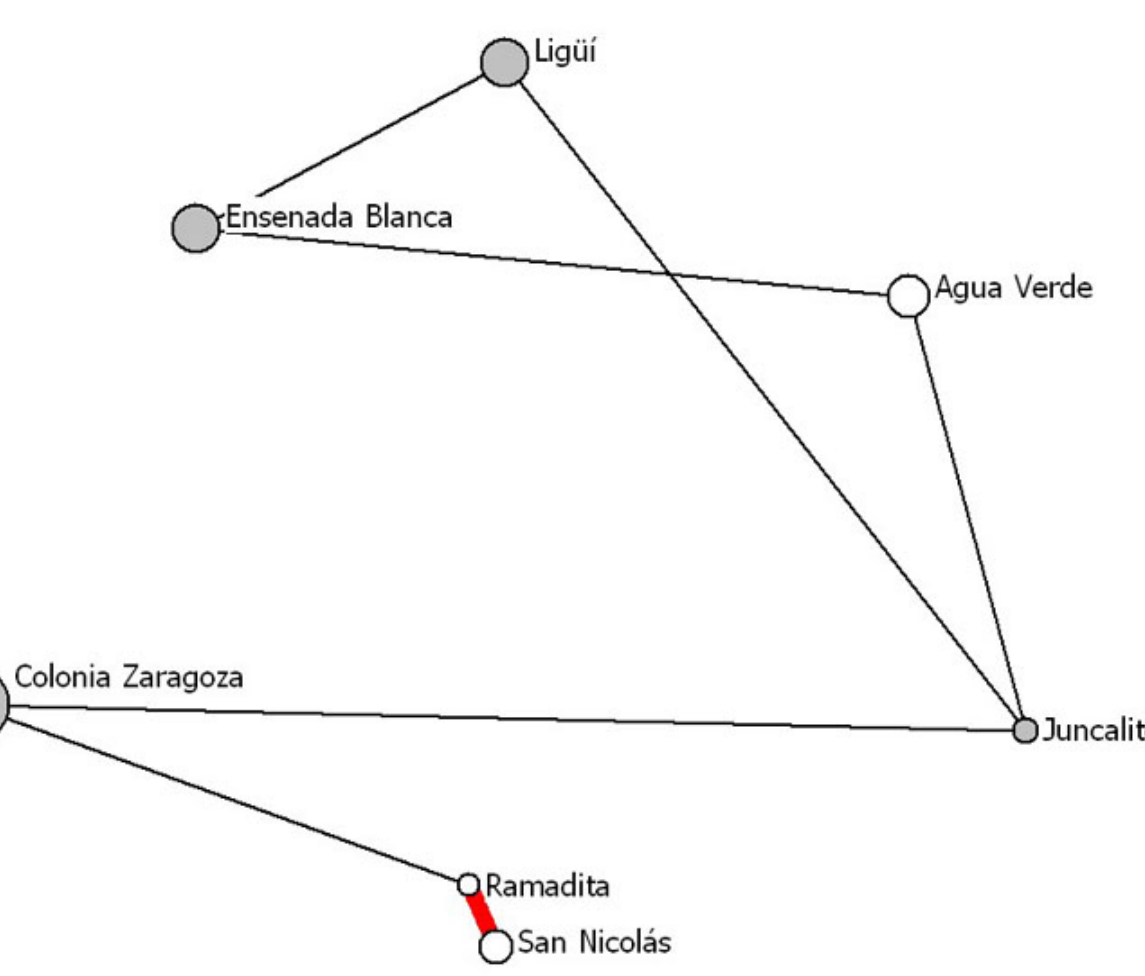
Fig. 6. Multi-dimensional scaling plot showing the kinship linking structure among the seven communities. The size of each node (community) is proportional to the number of fishers considered in each community; communities with high resource scarcity are shown with gray circles and communities with low resource scarcity are shown with white circles. The thickness of intercommunity links is proportional to the ratio of the measured vs. the expected number of relations. Thin line < 0.5 in black, medium line < 1 in blue, thick line > 1 in red. Ratio values less than 0.1 were